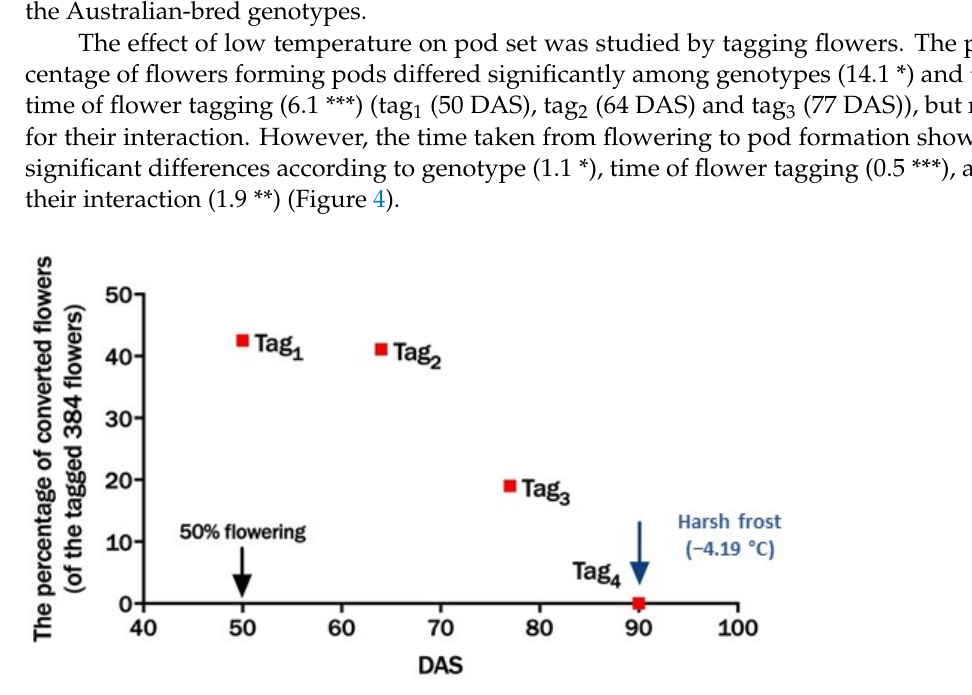
Figure 4. The percentage of pod formation from the tags at 50, 64, 77, and 90 days after sowing (DAS) in 2016/2017 at the Agricultural Research Station at Dirab.